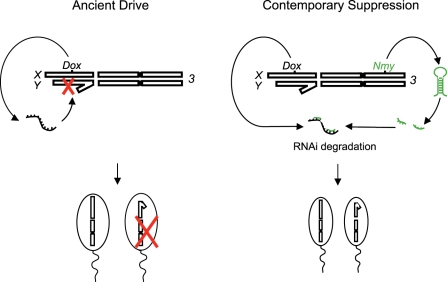
Mechanistic and Evolutionary Model for sex-ratio DistortionThe X-linked Dox gene first evolved to target an unknown component of the Y chromosome, so that Y-bearing sperm fail to develop. This leads to an increased transmission frequency of the Dox-bearing X chromosome and a female-biased sex ratio. It remains unclear whether Dox is an RNA or protein-coding gene. Later, a transposition of Dox to Chromosome 3 created the Nmy gene. siRNAs produced from the double-stranded hairpin of Nmy target the homologous region of Dox for degradation via the RNAi pathway. As a result, Y-bearing sperm develop normally, and X-chromosome meiotic drive is suppressed. The model depicts a pre-meiotic germ cell, but the cellular manifestation of distortion occurs during nuclear condensation and maturation of sperm. Only the sex and third chromosomes are shown.